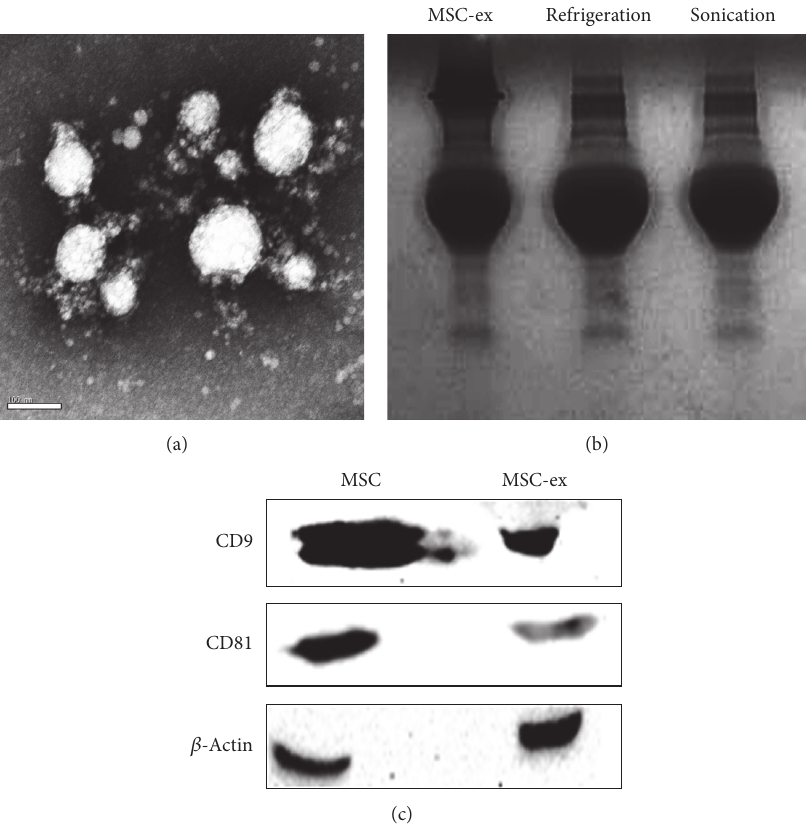
Figure 1: Characterization of exosomes from hucMSCs. (a) Transmission electron microscopy analysis of extracellular vesicles secreted by hucMSCs. Scale bar: 100 nm. (b) Coomassie Blue staining. The protein extracts of hucMSCs-exosomes were separated by SDS-PAGE. (c) Western blotting analyses of exosomal markers using antibodies against CD9 and